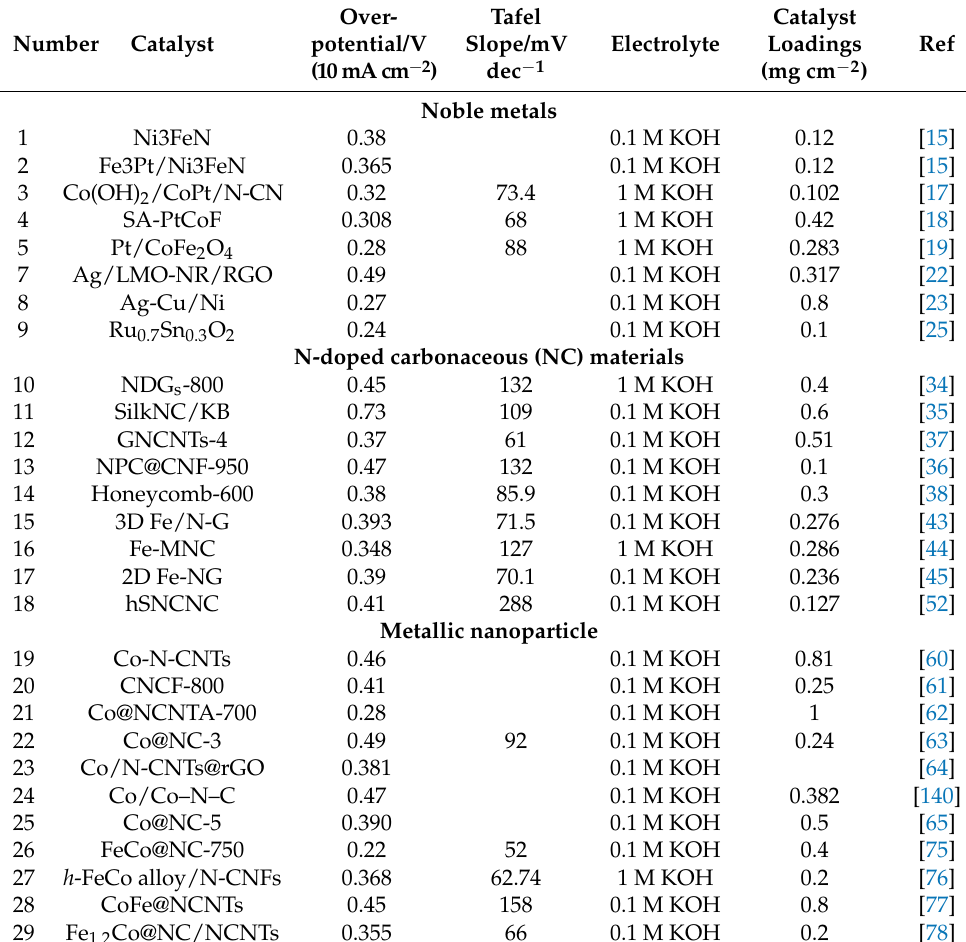
Table 3. OER performances of catalysts based on noble metals, N-doped carbonaceous materials, metallic nano particles, metal chalcogenides, layer doubled hydroxides, and metal